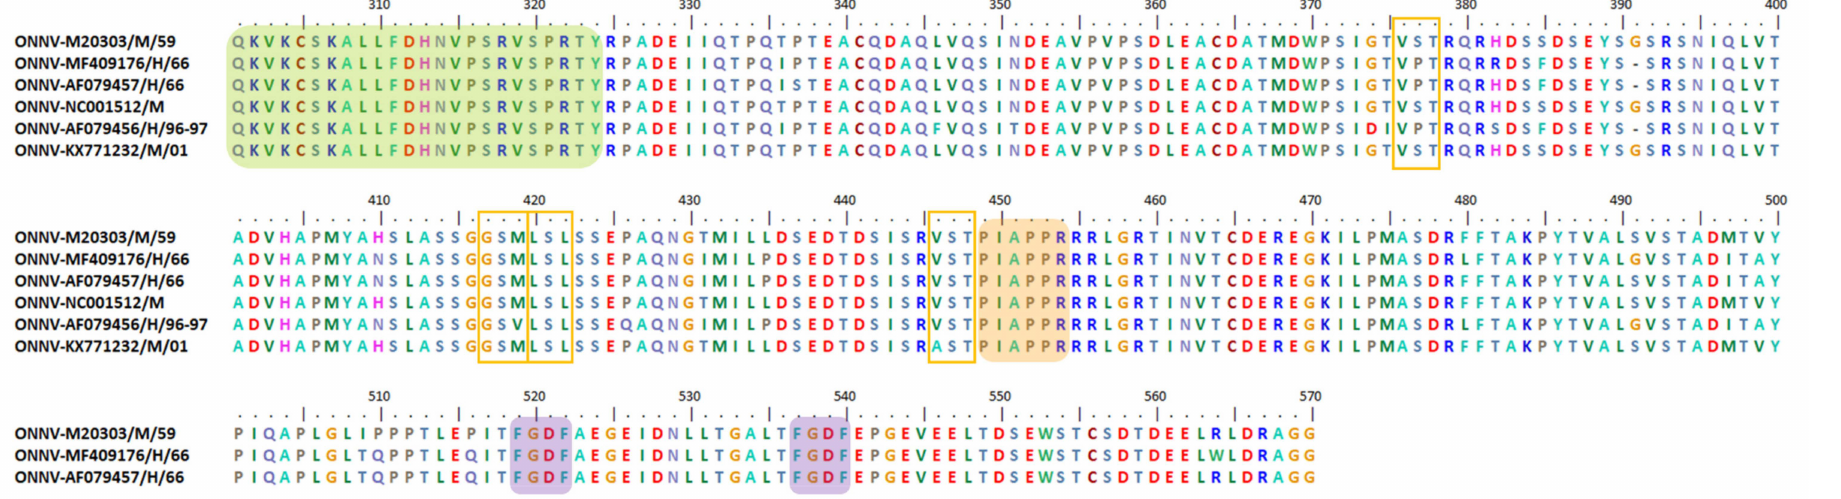
Figure 8. MSA and important motif locations in the nsP3 of selected ONNV strains. The HVD starts at position 325. It has one P-rich region at position 449–454 (peach) and two FGDF-like motifs at positions 519–522 and 538–540 (purple). The MF409176, AF079457, and AF079456 have 1 aa deletion at position 391. A predicted conserved motif, (V/A)(S/P)T, at positions 376–378 and 446–448; GS(M/V) at position 417–419; and LSL at 420–422 have been observed (orange